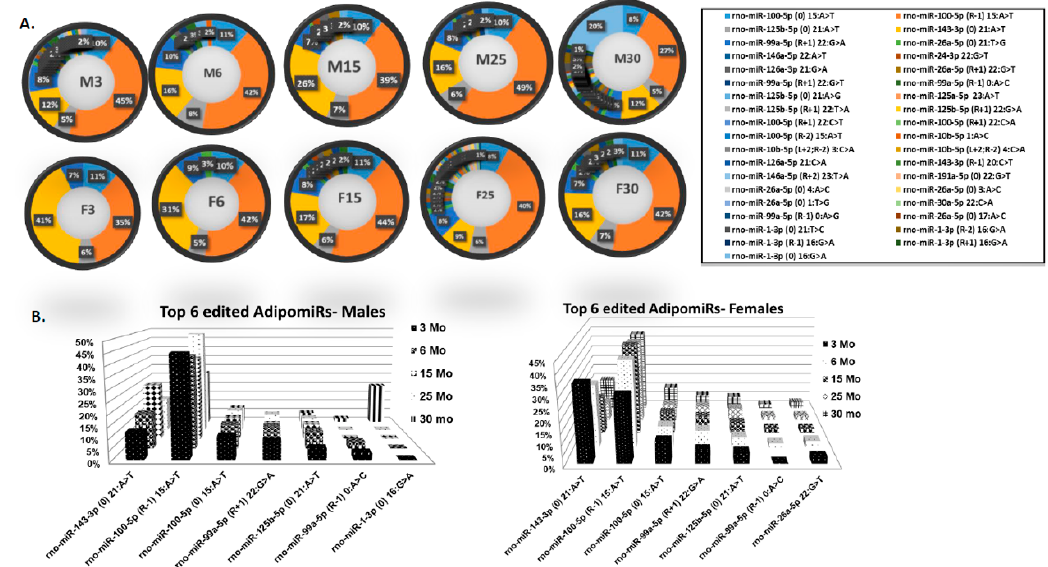
Figure 5. Longitudinal changes in edited adipomiRs: ( A ) Quantitative analysis of the edited adipomiRs from male and female FBN rats as determined by small-RNA sequencing. Each doughnut chart represents the percent of the highly edited adipomiRs in each age group in the two sexes. The larger the slice within the doughnut graph, the larger editing of that individual adipomiR. The table provides the IDs of the adipomiR represented in the slices of the doughnut graphs. ( B ) The graphical representation of the top 6 highly edited adipomiRs at each age group in both the sexes.